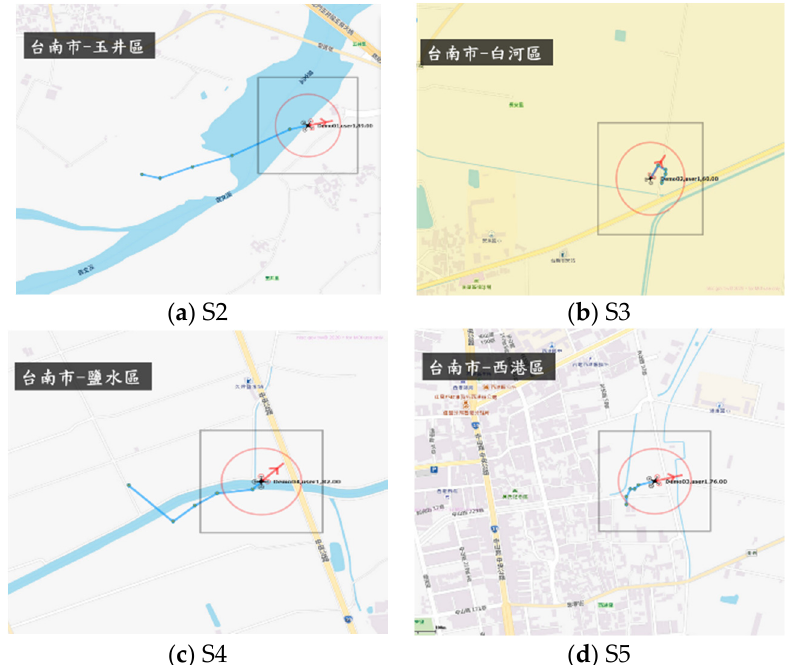
Figure 13. Immediate test after GTS site installation.